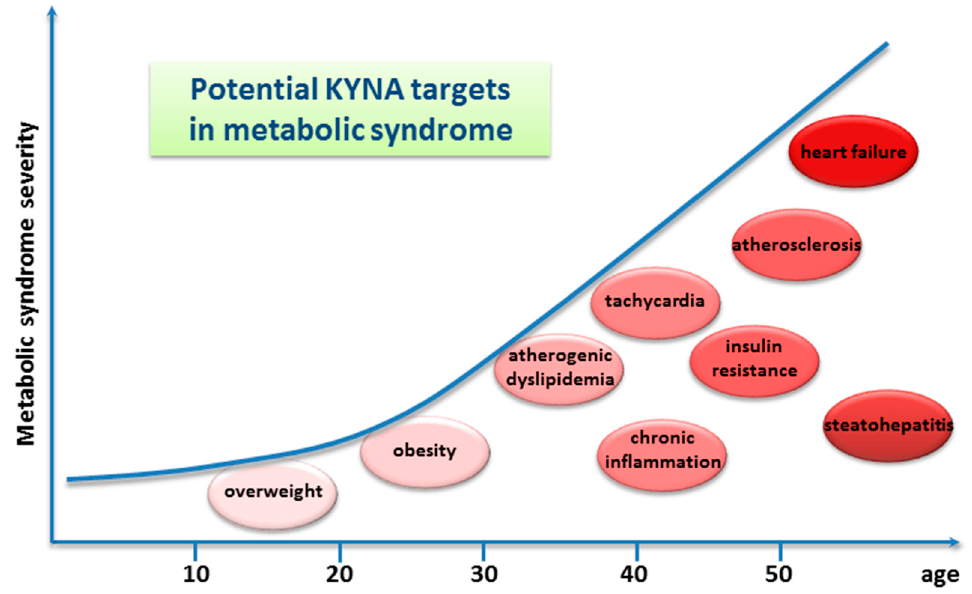
Figure 4. Graphic presentation of potential kynurenic acid (KYNA) targets in metabolic syndrome in humans. The effects of KYNA in specific pathological conditions drawn from animal studies are described in the text and are presented in Table S7. The graphic is based on [96]; however, only identified KYNA targets are presented.